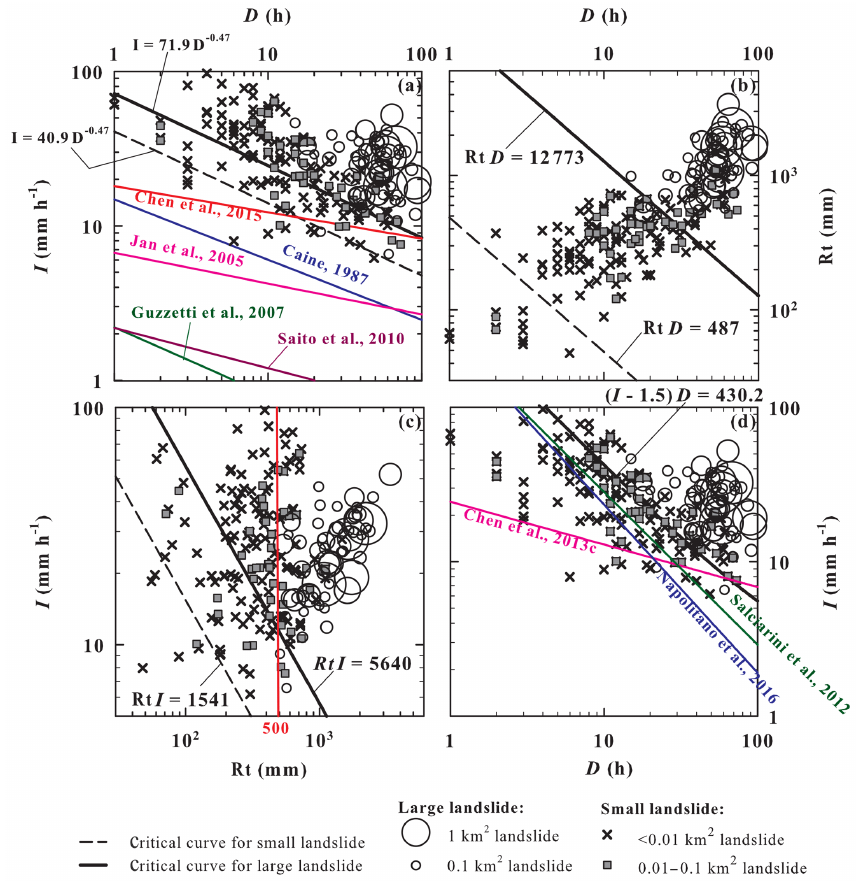
Figure 6. (a) I – D rainfall threshold. (b) Rt– D method rainfall threshold. (c) I –Rt method rainfall threshold. (d) Threshold of the critical height of water model, ( I − 1 . 5 )D = 430 . 2.